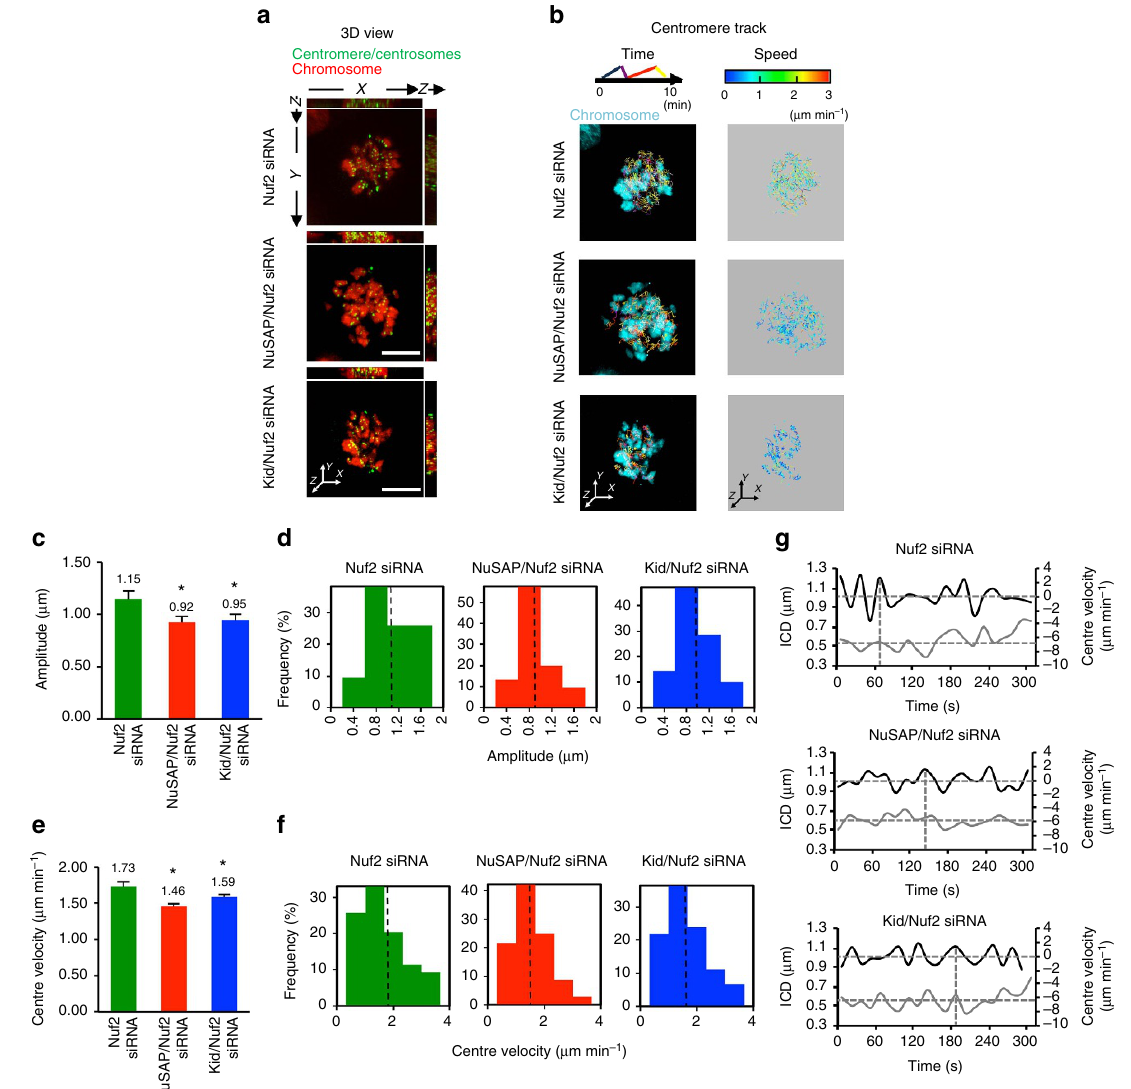
Figure 4 | NuSAP and Kid regulate centromere movement at interpolar microtubules. ( a ) Representative images of the 3D view using xz and yz projections in Nuf2-, NuSAP/Nuf2- or Kid/Nuf2-depleted synchronized metaphase HeLa cells stably expressing mCherry-H2B. Centromeres were marked with GFP-CENPA and centrosomes with GFP-centrin. Scale bar, 5 m m. ( b ) Representative images of the 3D centromere tracks colour-coded for time and velocity. ( c , d ) Bar chart and histogram representing the average ( c ) and the distribution ( d ) of the amplitude of centromere oscillation in Nuf2-, NuSAP/Nuf2- or Kid/Nuf2-depleted metaphase cells. Error bars represent þ s.e.m. * P o 0.001, by t -test. ( e , f ) Bar chart and histogram representing the average ( e ) and the distribution ( f ) of the centre velocity. Error bars represent þ s.e.m. * P o 0.001 by t -test. ( g ) Representative velocity (black line) and ICD (grey line) versus time plots of the projected centre in a sister centromere pair in Nuf2-, NuSAP/Nuf2- or Kid/Nuf2-depleted metaphase cells. The sign of the velocity indicates the direction of centromere movement. The average of the ICD (horizontal) and the minimum (horizontal) and maximum velocities (vertical) are indicated by the dashed lines. in control cells (1.58 m m min (cid:2) 1 ; Fig. 6e,f). The significant monopolar cells. The representative 3D time-lapse live-cell ima- ges and centromere tracks (Fig. 6a,b and Supplementary Movie 5) decrease in oscillation velocity and amplitude in both the show that oscillation was dramatically retarded with a significant NuSAP/Nuf2- and Kid/Nuf2-depleted cells suggests that NuSAP decrease in velocity in the NuSAP/Nuf2- and Kid/Nuf2-depleted strongly regulates the forces on iMTs, particularly the PEF cells (Fig. 6b, lane 2, middle and bottom). generated by Kid. Compared with the depletion of Kid/Nuf2, The amplitude of oscillation at the centre point in NuSAP/ co-depletion of NuSAP and Nuf2 had a greater effect on Nuf2 (0.56 m m)- and Kid/Nuf2 (0.66 m m)-depleted monopolar chromosome oscillation (Fig. 6e,f, lane 2). This indicates that cells was also significantly reduced compared with that in control NuSAP might also facilitate other PEFs at iMTs besides that cells (0.83 m m), as shown by the substantial decrease in both the generated by Kid. The linkage between velocity and ICD during average amplitude (Fig. 6c) and the proportion in the 1-2 m m oscillation was also dramatically reduced in Nuf2-, NuSAP/Nuf2- range (Fig. 6d). Moreover, the centre velocity was significantly and Kid/Nuf2-depleted monopolar cells, with extremely random attenuated in NuSAP/Nuf2 (1.03 m m min (cid:2) 1 )- and Kid/Nuf2 movements observed (Fig. 6g; vertical dotted lines). This is (1.21 m m min (cid:2) 1 )-depleted monopolar cells compared with that consistent with our previous results (Figs 3–5g) showing that NATURE COMMUNICATIONS|7:10597|DOI: